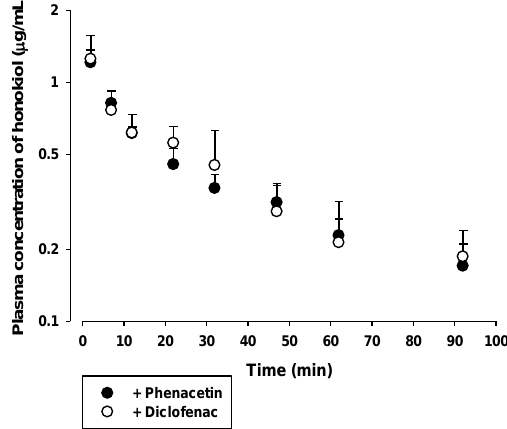
magnolol tended to be similar between the two rat groups treated with phenacetin and diclofenac. The highest plasma levels of honokiol and magnolol observed at 2 min were 0.9‒1.6 μg/mL and 3.1‒ 5.5 μg/mL, respectively.